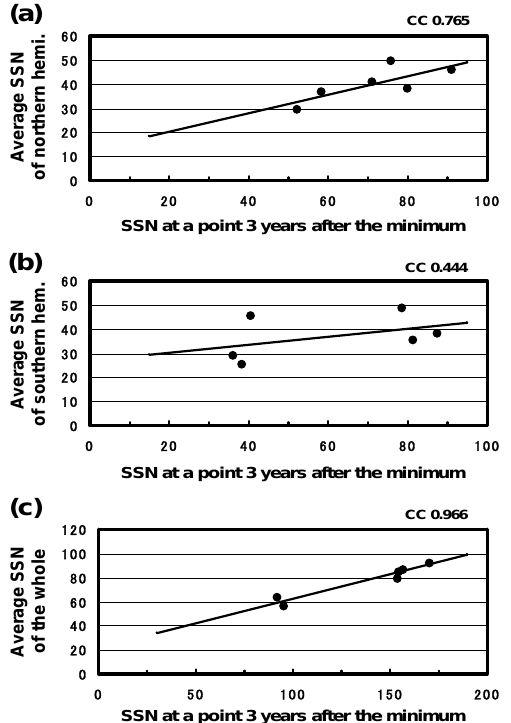
Figure 3. (a) Scatterplot of average SSN versus SSN 3 years after the minimum for the data of Northern Hemisphere. (b) Same as panel (a) but for the data of Southern Hemisphere. (c) Same as (a) but for the data of the whole sphere. The correlation coefficient and its lower and upper limits of the 95% confidence interval are 0.764, − 0.123 and 0.972 for the case (a) , 0.444, − 0.574 and 0.923 for the case (b) , and 0.966, 0.717 and 0.996 for the case (c) , respectively. In these plots we used the SSN data during cycles 18 to 23 obtained by the National Astronomical Observatory of Japan by obtaining 13-month